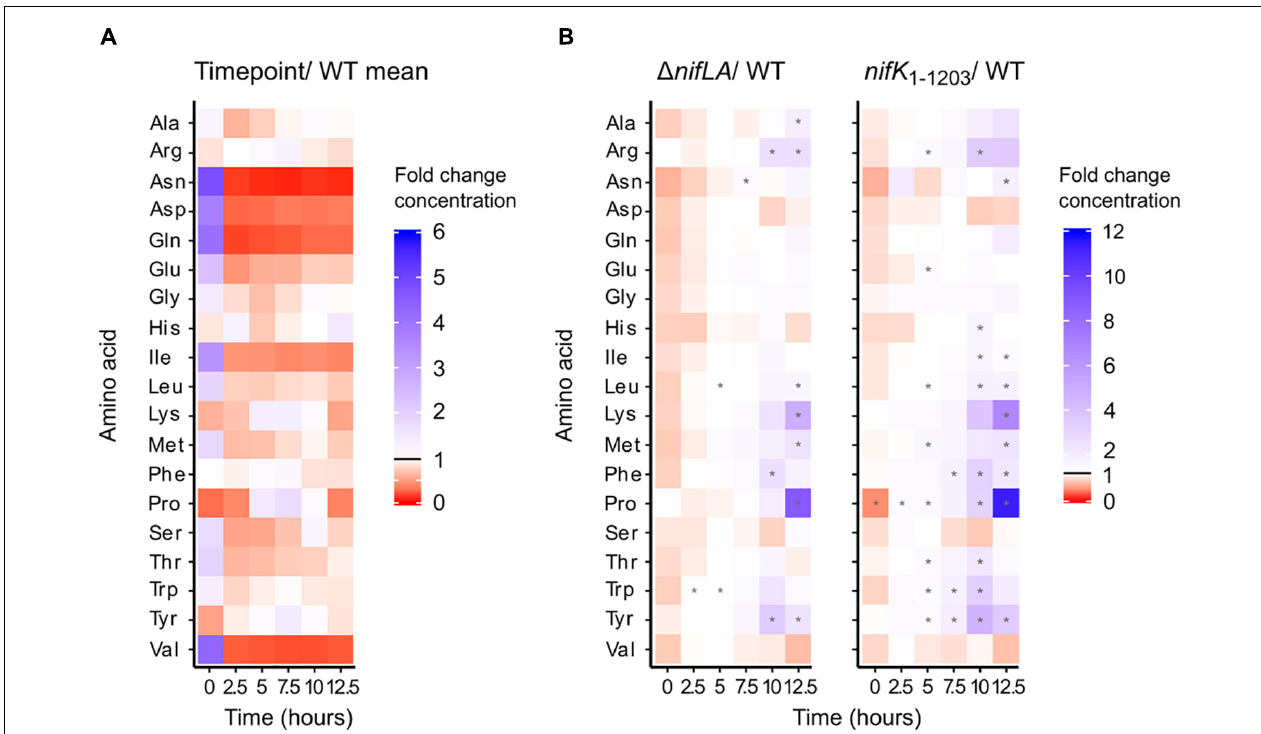
FIGURE 6 | Dynamics of the intracellular amino acid pools during the diazotrophy transition. Ko M5a1 wild-type, nifK 1 − 1203 , and (cid:49) nifLA strains were cultured for 12.5 h in NFDM medium supplemented with 0.5 mM NH 4 Cl. Polar metabolites were extracted at 2.5 h intervals, derivatised with the AccQTag reagent (6-aminoquinolyl- N -hydroxysuccinimidyl carbamate) and analyzed via LC–MS. Absolute amino acid concentrations were calculated by referencing external standard curves, assuming a characteristic cell volume of 10 − 15 L. (A) Time course of wild-type amino acid pools. Heat map density representative of fold-change between time-specific concentrations and the base mean amino acid concentration across all time points. Asterisks denote statistically significant differences from base mean (one sample unpaired Student’s t -test, N = 3, p < 0.05). (B) Time course of (cid:49) nifLA and nifK 1 − 1203 amino acid pools. Heat map density representative of fold-change between (cid:49) nifLA and nifK 1 − 1203 amino acid concentrations and wild-type. Asterisks denote statistically significant differences between mutant and wild-type means (two sample unpaired Student’s t -test, N = 3, adjusted p -value (False Discovery Rate; Benjamini and Hochberg, 1995; p < 0.05). Note different heat map density scales between panels (A,B) . Absolute amino acid concentrations are detailed in Supplementary Data 3